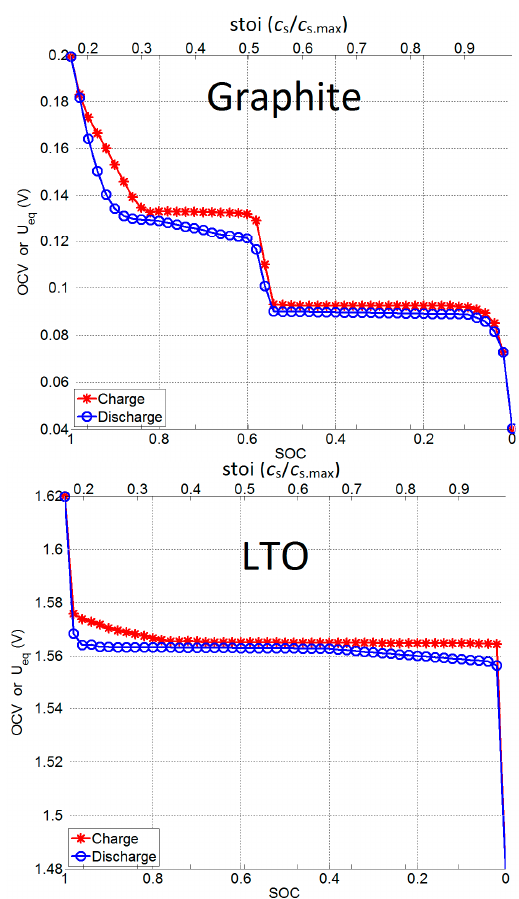
U measurement vs. state of charge (SOC) for graphite and Li 4 Ti 5 O 12 anode. Figure 1. OCV or Figure 1. OCV or U eq measurement vs. state of charge (SOC) for graphite and Li 4 Ti 5 O 12 anode. eq